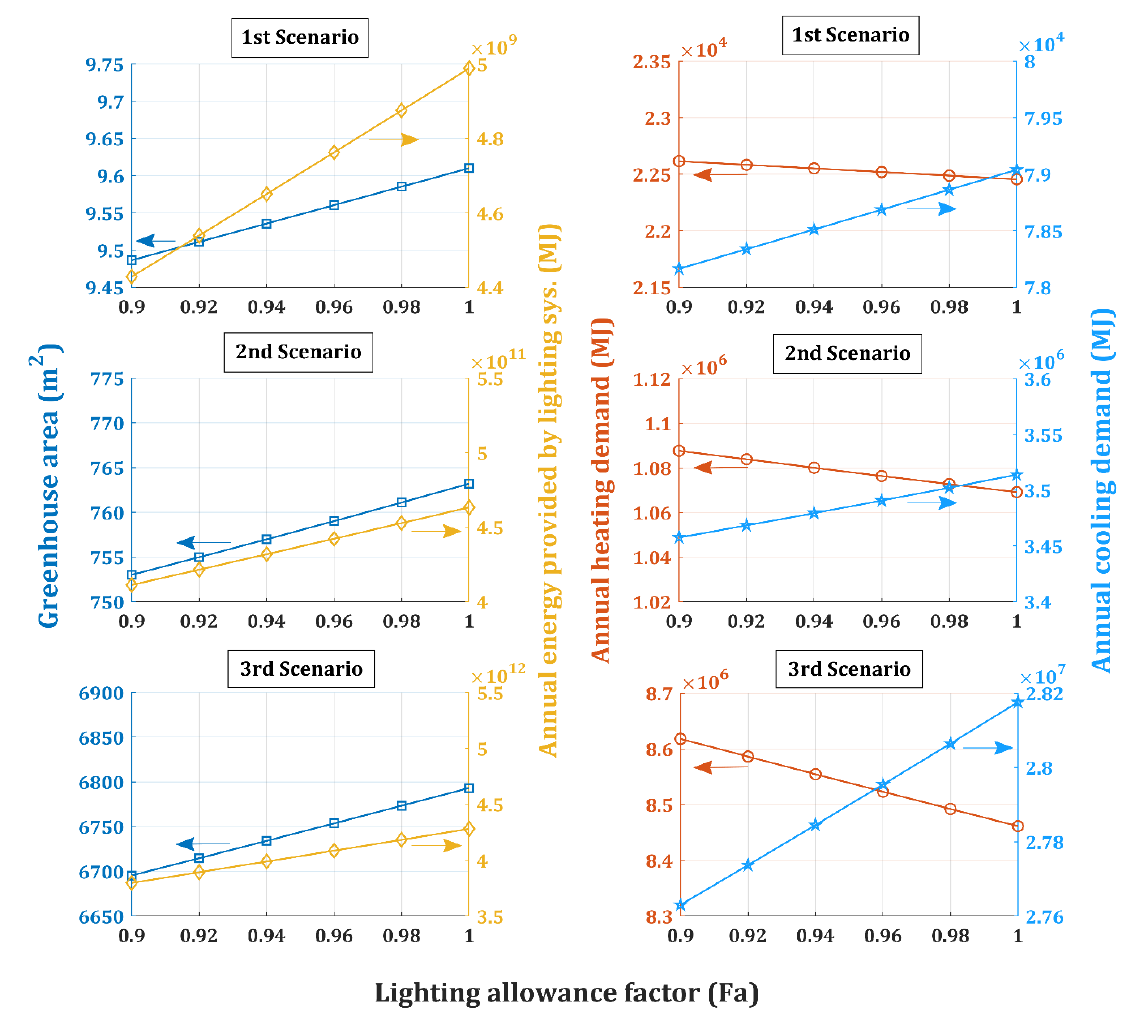
Figure 16. Variations in the greenhouse sizes, annual heat provided by supplementary lighting, an- nual heating demand, and annual cooling demand under the variation of the lighting allowance factor.